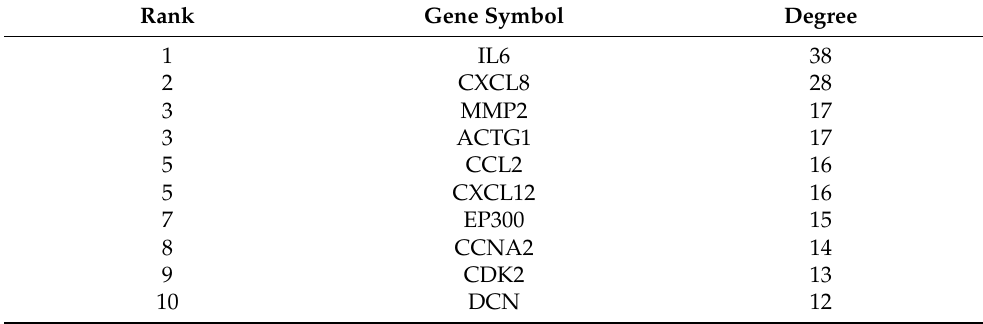
Figure 5. PPI network of all DEGs. Red indicates high connection degree, while yellow represents low. Node size also indicates the connection degree: the higher the degree is, the larger the node size. Nodes with star labels represent hub genes analysed by the cytoHubba. Table 2. The top 10 hub genes.